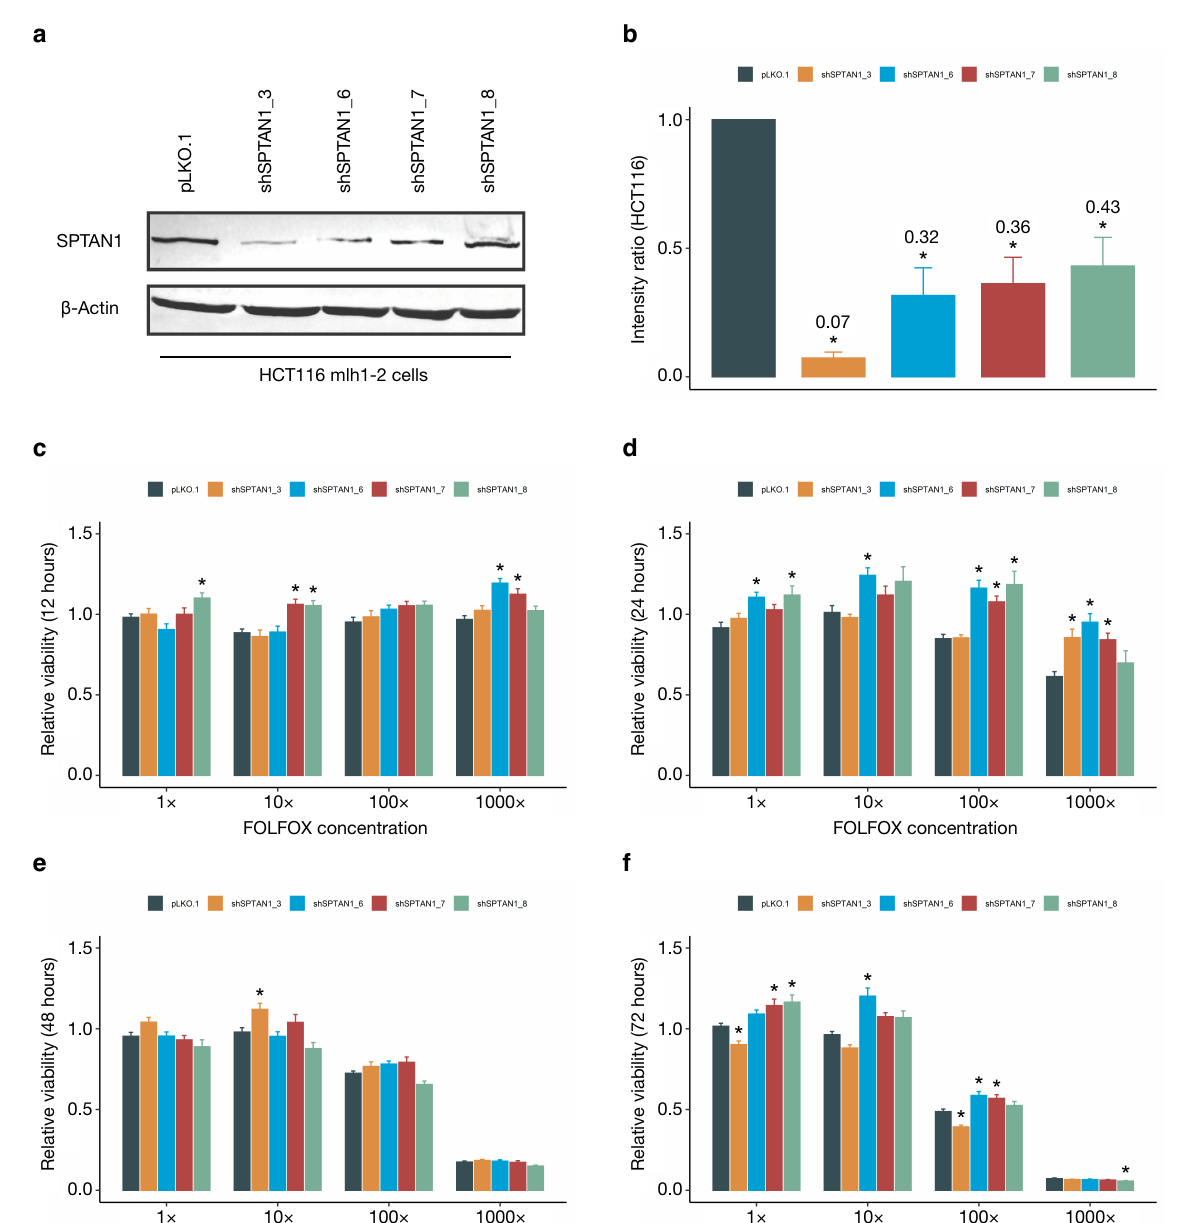
Figure A1. HCT116 mlh1-2 cells with SPTAN1 knockdown are less responsive to FOLFOX chemotherapy. Short hairpin RNAs were used to knock down SPTAN1 expression in HCT116 mlh1-2 colon cancer cells ( a ). Western blot band intensities were quantified by digital image analysis, to determine SPTAN1 protein levels of knockdown cells relative to control- transduced cells (denoted pLKO.1) ( b ). Bar charts illustrating the response to FOLFOX chemotherapy in HCT116 mlh1-2 colon cancer cells with stable knockdown of SPTAN1 expression ( c – f ). Cell viability in response to incremental doses of FOLFOX chemotherapy was measured by tetrazolium dye (MTT) colorimetric assay after ( c ) 12 h, ( d ) 24 h, ( e ) 48 h, and ( f ) 72 h. Data represent averages from three independent experiments, totalling up to 48 individual absorbance readings for each combination of knockdown strain, timepoint and chemotherapy dose. Absorbance readings of FOLFOX-treated cells were normalised to the average absorbance values of the respective control-treated cells. SPTAN1 knockdown cells and control-transduced cells (denoted pLKO.1) were compared by one-way ANOVA. Differences between individual knockdown strains and the reference group (control-transduced cells) were assessed by Dunnett’s post-hoc test, and denoted with an asterisk (*) if they reached statistical significance. Results with a p -value < 0.05 were considered statistically